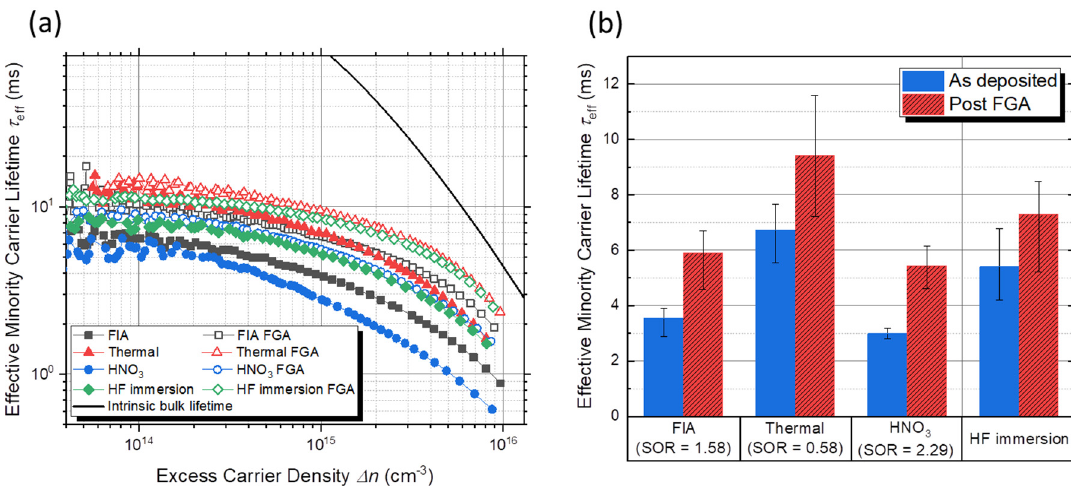
Figure 5. ( a ) Values of τ eff measured as a function of ∆ n for n -Si wafers symmetrically passivated by SiO x and SiN x stack before (solid symbols) and after (open symbols) forming gas anneal (FGA). The ∆ n dependent τ eff for samples passivated with thin FIA SiO x (dark-grey squares) capped with SiN x layer is compared to those passivated by thin thermal SiO x (red triangles) and HNO 3 SiO x (blue circles) when capped with SiN x . The τ eff of samples passivated with a single layer SiN x after hydrofluoric acid (HF) immersion (green diamonds) is shown for reference. ( b ) Values of τ eff obtained at ∆ n = 1 × 10 15 cm − 3 for samples passivated with different thin SiO x and SiN x stacks and with a single layer SiN x before and after FGA. Three samples were measured for each group with the solid columns showing the mean and error bars representing the minimum and maximum. The sub-oxide ratio (SOR) is included in the category label with the oxide preparation method.